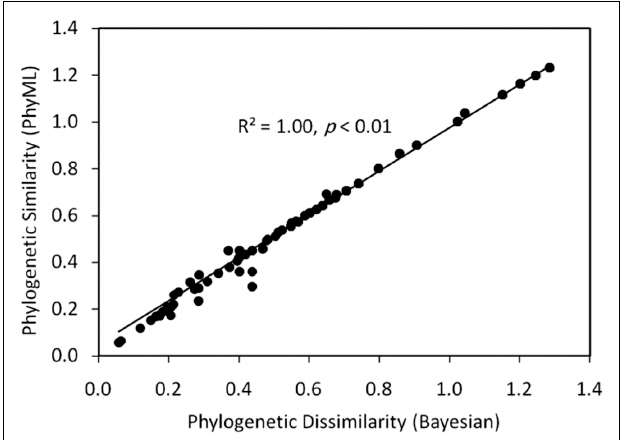
FIGUREA1 | Plot of a Mantel regression of a matrix describing the Rao phylogenetic dissimilarity of concatenated HDK homologs inferred by PhyML as a function of the Rao phylogenetic dissimilarity of concatenated HDK homologs inferred by MrBayes. The strong positively trending correlation suggests that the topologies of the two trees are